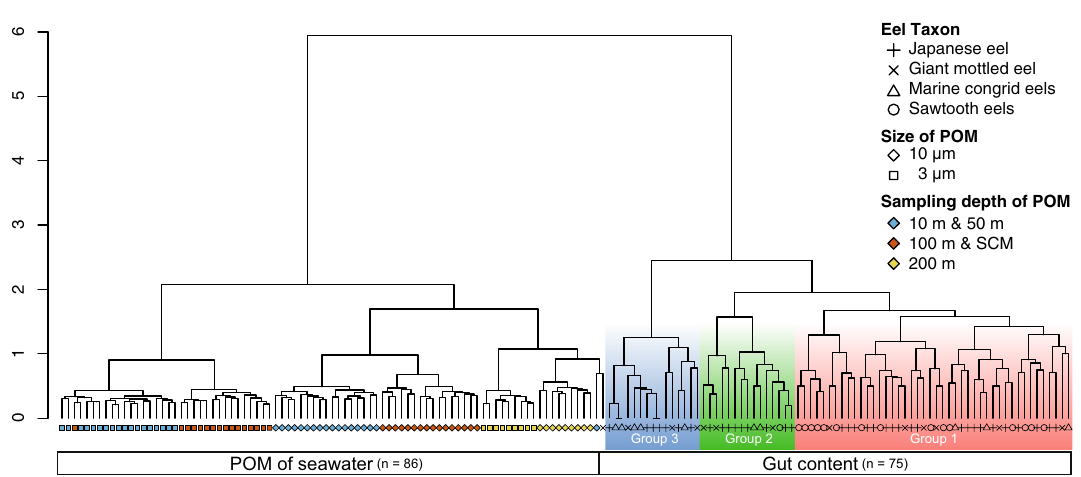
Figure 5. Cluster dendrogram based on eukaryotic compositions in eel gut contents and POM of seawater. POM samples classified into two sizes (10 μm, diamond ◇ and 3 μm, square □ ) and three sampling depths (10 m & 50 m: blue; 100 m & the SCM: red; 200 m: yellow). Based on the gut content samples, three well-defined cluster groups (Group 1: red, Group 2: green, Group 3: blue) were